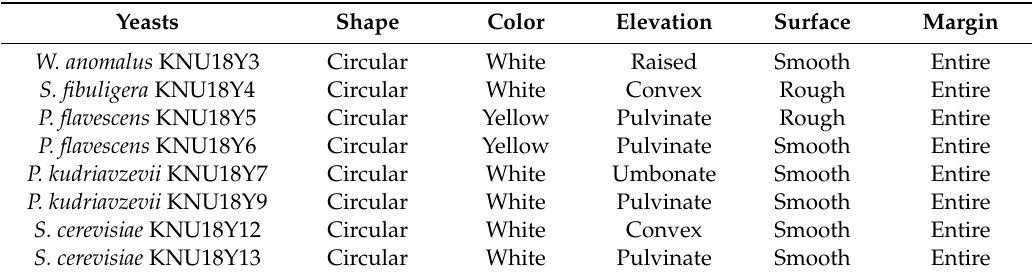
Table 2. Morphological features of the eight yeast colonies.